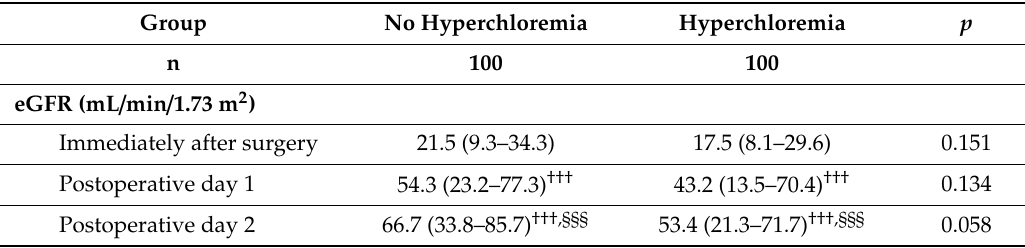
Table 4. Serial changes in estimated glomerular filtration rate during postoperative day 2 between propensity score-matched non-hyperchloremia and hyperchloremia